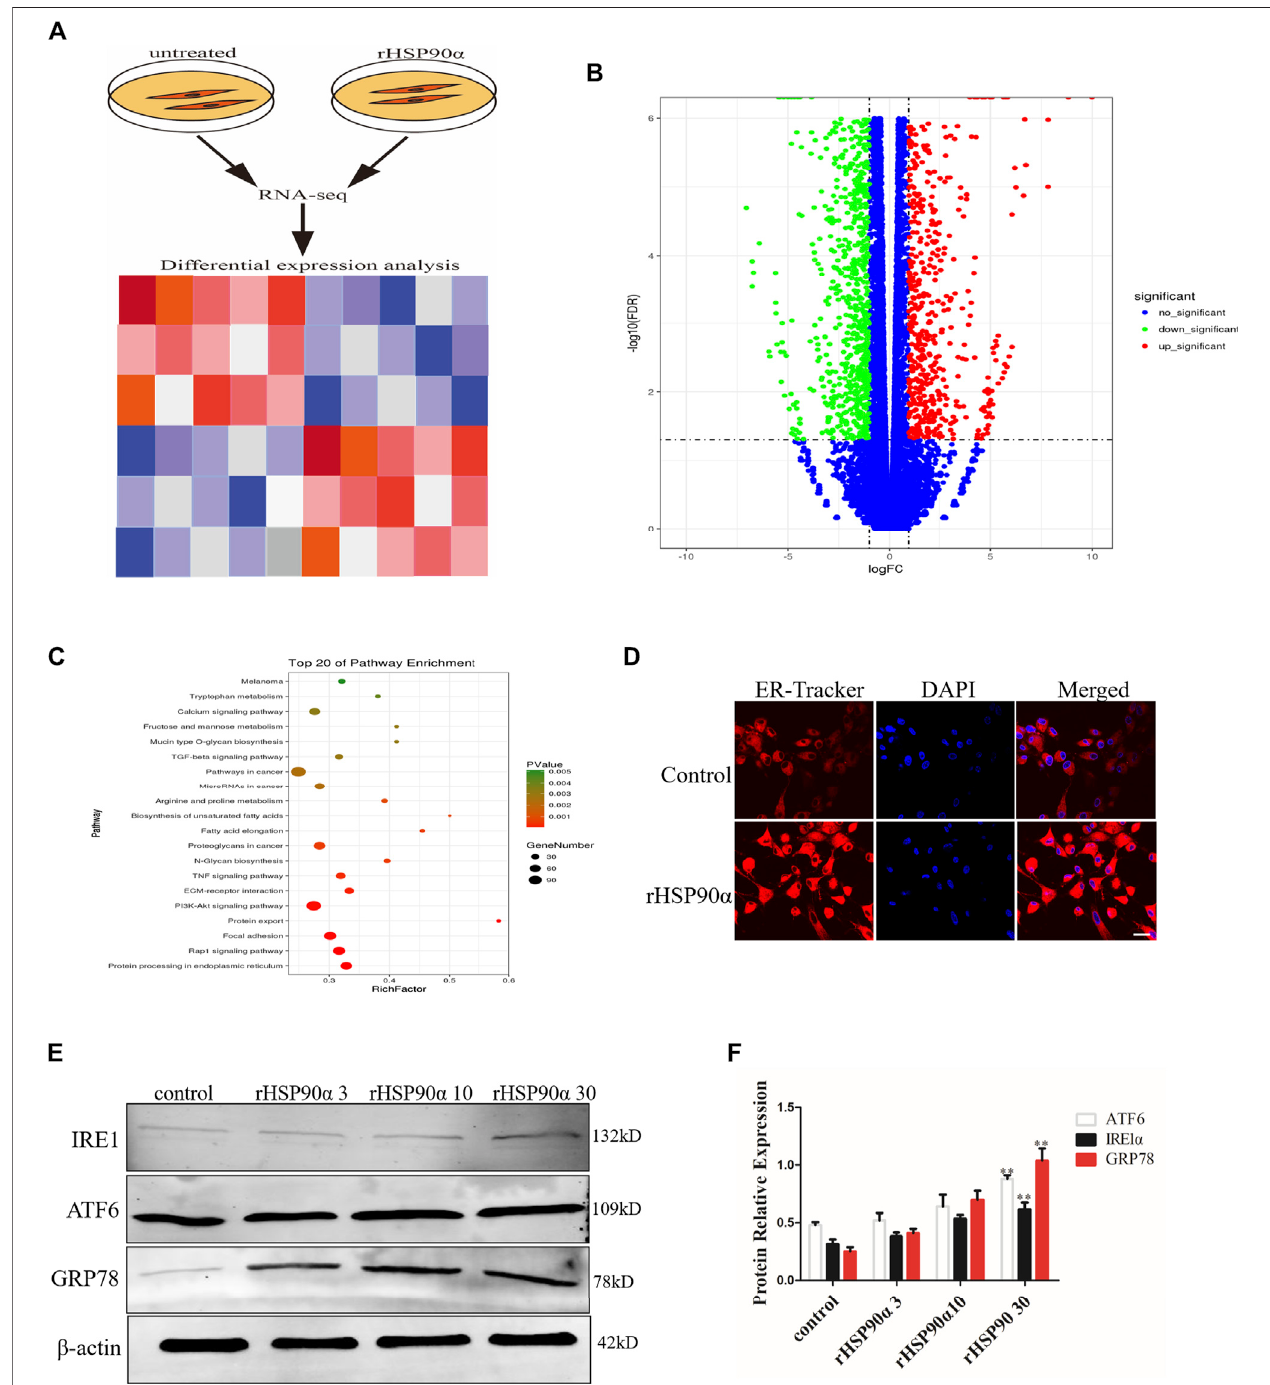
FIGURE 2 | Extracellular HSP90 α induces ER Stress in lung fi broblasts. (A) . Schematic diagram of RNA-seq with or without rHSP90 α treatment. (B) . Volcano plot displays the overall genes identi fi ed with a p < 0.05 and |log2FC| > 1.0 a cutoff. (C) . KEGG pathway analysis of pathway enrichment. The vertical axis represents the pathway category and the horizontal axis represents the enrichment score [ − log ( p -value)] of the pathway. Signi fi cantly enriched KEGG pathways ( p < 0.05) are presented. The data were analyzed by DAVID bioinformatics tools. (D) . Endoplasmic reticulum (ER) activity was assessed by immuno fl uorescence staining ER- Tracker. Representative staining images of ER-positive cells and DAPI (blue) showing nuclei under confocal laser scanning microscopy (scale bar (cid:1) 50 μ m). (E,F) . Western blot analysis of expression of ATF6, IRE1 α and GRP78 after different concentrations of rHSP90 α treatment for 24 h, β -actin was used as an internal control. * p < 0.05, ** p <